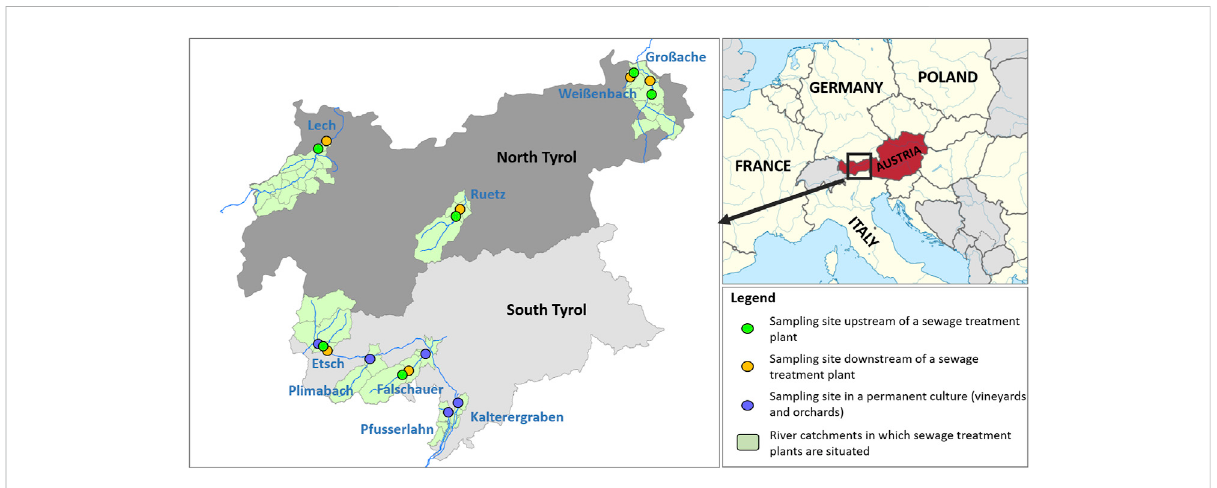
FIGURE 1 MapofEuropeandaugmentedMapofNorth-andSouthTyroldisplayingthelocationandtypeofthesamplingsites.Namesofriversarelabeled in